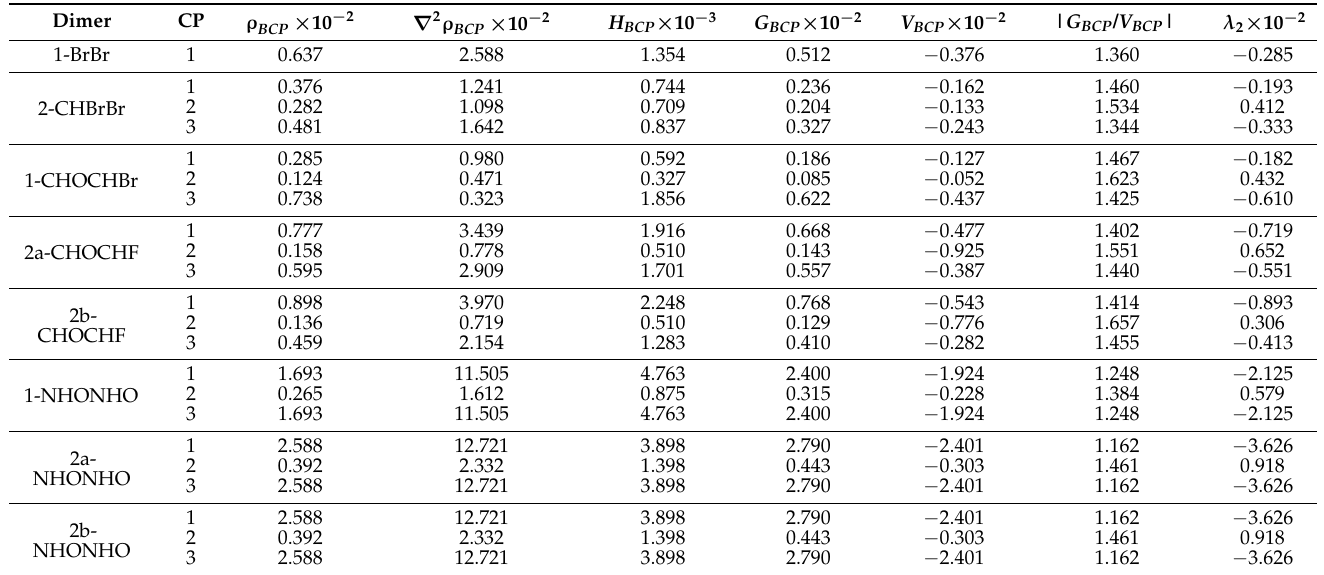
Table 3. Values of the electron density ρ BCP , Laplacian of the electron density, ∇ 2 ρ BCP , energy density, H BCP , Lagrangian kinetic energy, G BCP , potential energy density, V BCP the ratio of Lagrangian kinetic energy over by potential energy density, | G | and second eigenvalue, λ 2 , obtained at the critical points of the dimers with quantum theory of atoms in BCP / V BCP molecules (QTAIM) calculation. All values are in atomic units. The results were obtained with the MP2/def2-TZVP theory